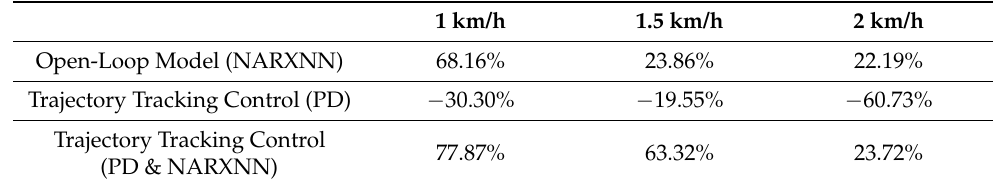
Table 3. Control strategies performance (GOF) for phase I protocol.